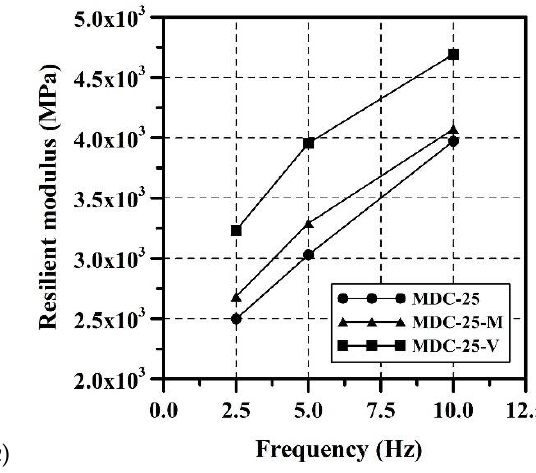
Figure 6. Resilient modulus MDC-25, MDC-25-M, and MDC-25-V: ( a ) 10 ◦ C; ( b ) 20 ◦ C; ( c ) 30 ◦ C.